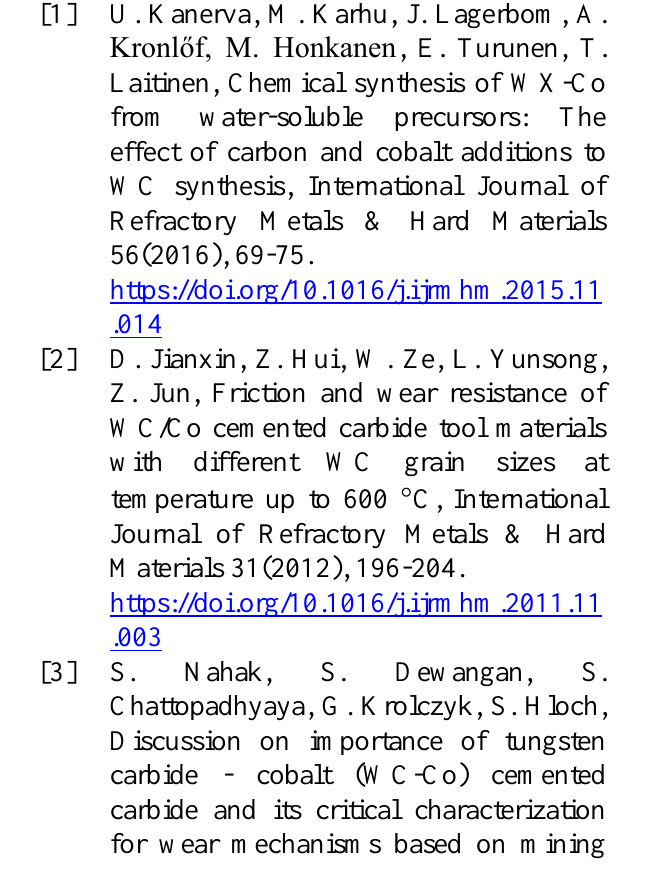
Average technological dissipation